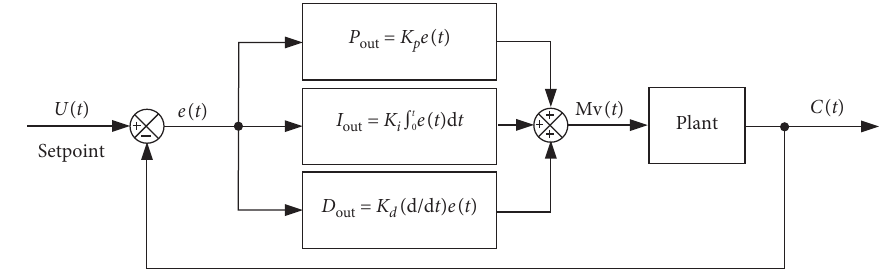
Figure 6: Block diagram of PID